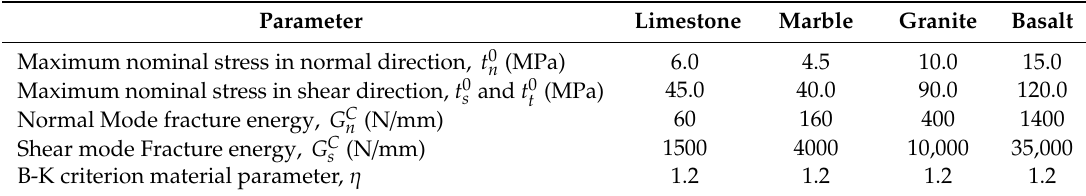
Table 4. Material properties of aggregate internal interfaces (AIIs). Parameter Limestone Marble Granite